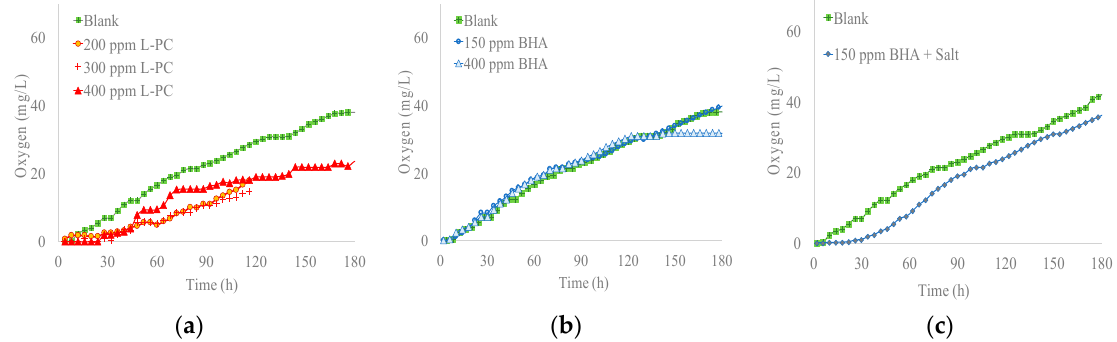
Figure 3. ( a ) Respirometry of L-PC; ( b ) Respirometry of BHA; ( c ) Respirometry of BHA with salt.